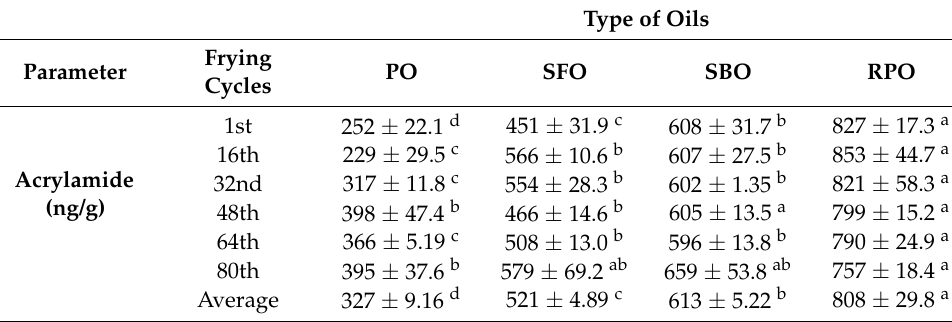
Table 5. Acrylamide concentration across 80 frying